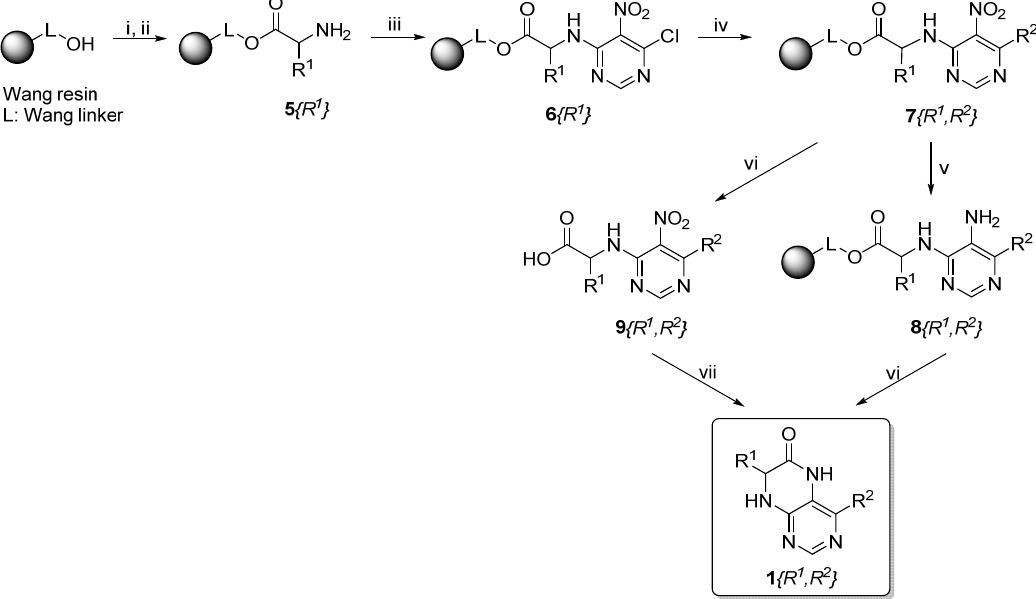
Table 1. Overview of synthesized dihydropteridinones 1